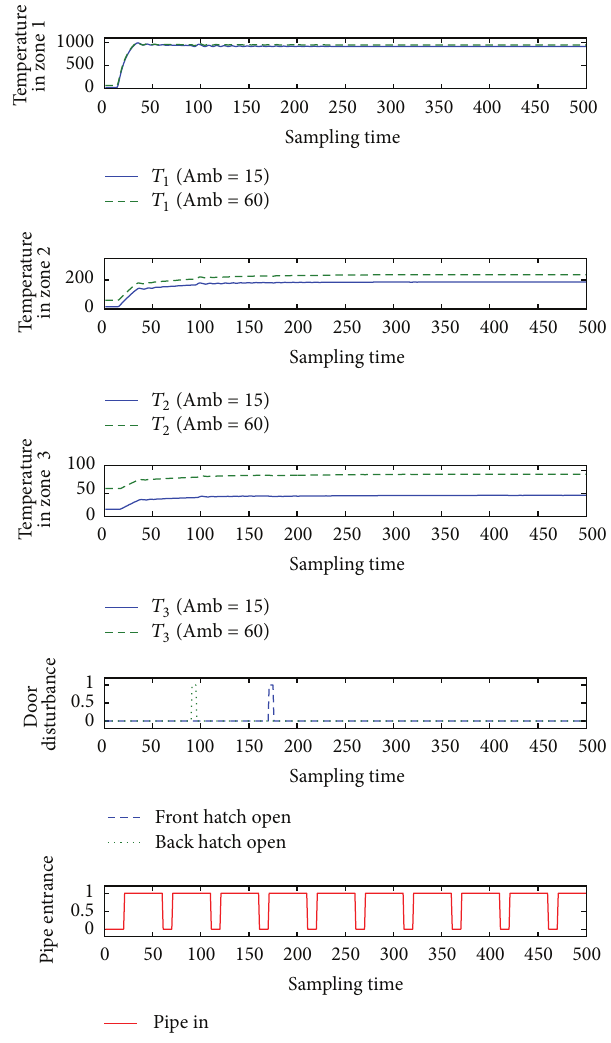
Figure 3: Influence to the zones from control input 1 with respect to the